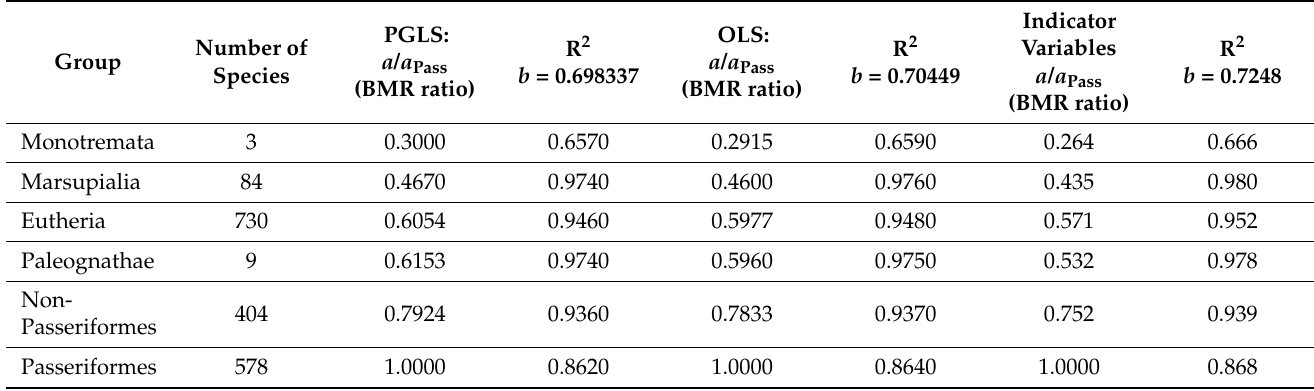
Table 3. The dimensionless quantity of the BMR ratio in the main clades of endotherms defined in different ways.